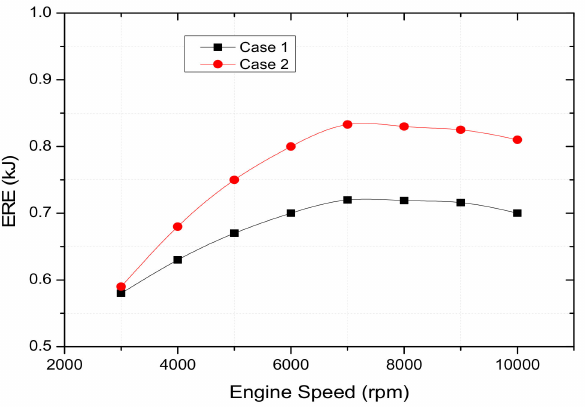
Figure 10. Comparison of ERE between the original and new valve